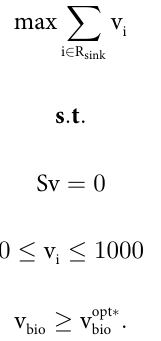
S3 Fig. Precision and recall of recovered reactions by COMMIT after removing reactions from a two-species community. COMMIT was run with (cond.) and without